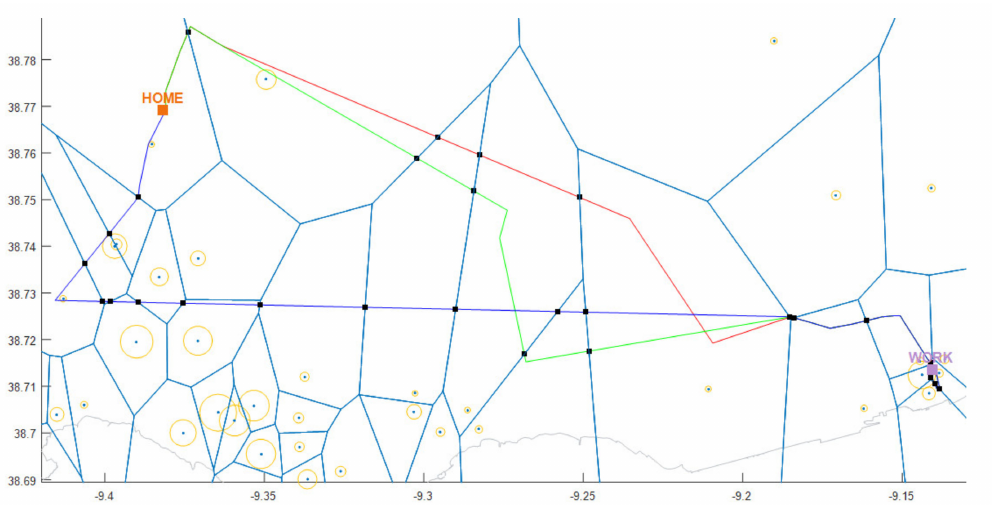
Figure 13. An example showing points (marked with black solid circles) on the visited cell tower’s Voronoi boundaries that each route passes through, by using the visited Voronoi-based